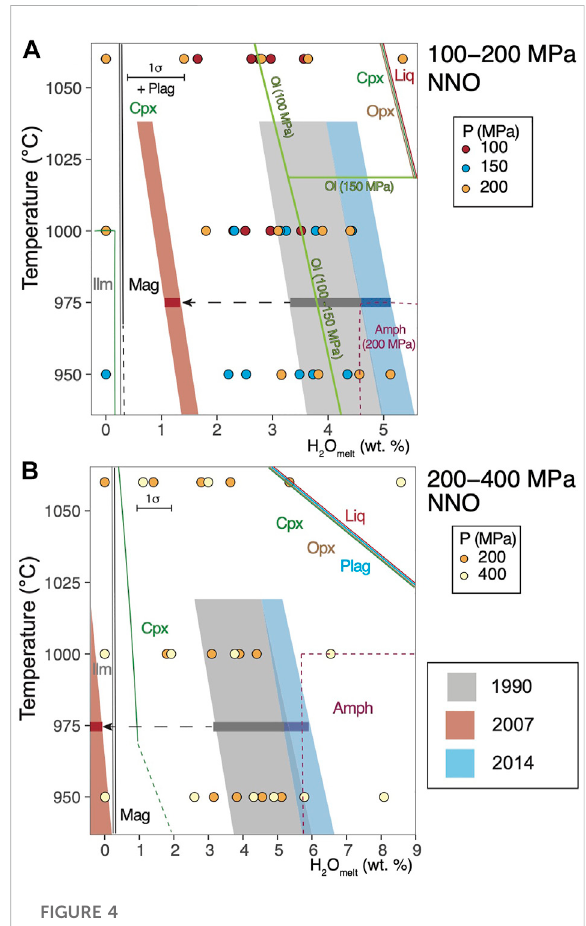
FIGURE 4 Phase relations for (A) 200 – 400 MPa, NNO; (B) 100 – 200 MPa, NNO. Gray, red and blue semi-transparent boxes represent the same parameters as Figure 3. Dashed lines denote inferred phase stability fi elds at the given temperature and water content. Dashed arrows indicate potential degassing pathways for the 2007 dome. Mineral name abbreviations are the same as in Figure 1, with the addition of Liq for liquid and Ilm for ilmenite. Pressure-speci fi c stability is speci fi ed next to the boundary line. Red line with ‘ liq ’ represents the liquidus boundary at the given pressure and temperature.